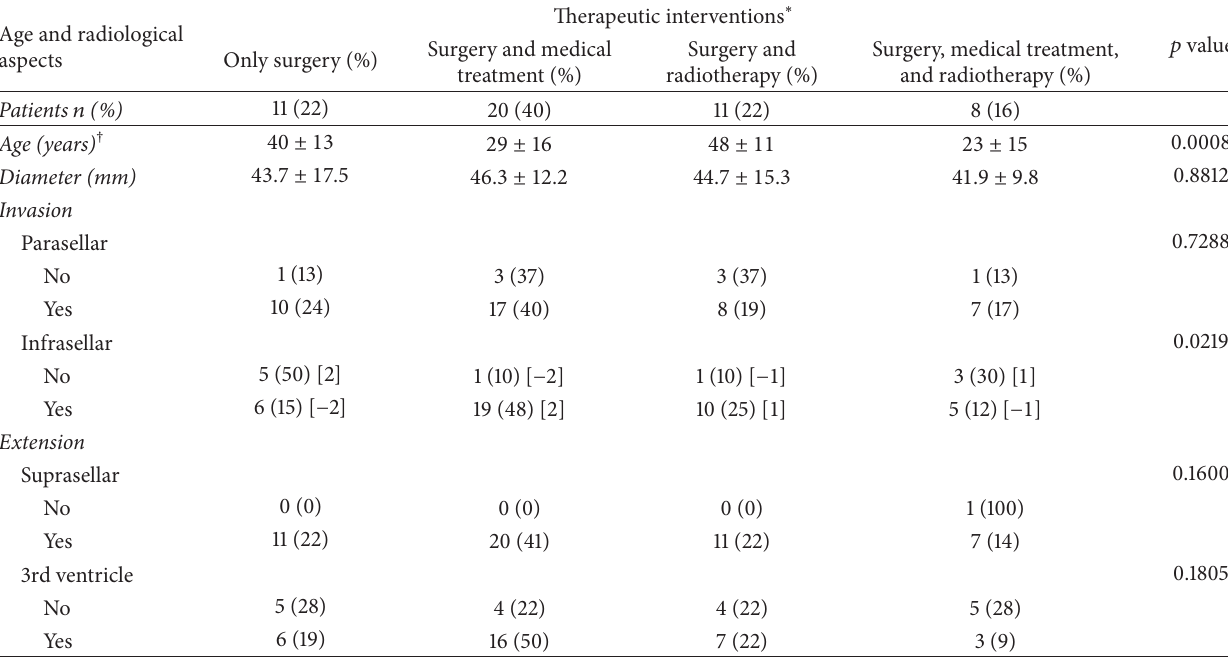
Table 4: Clinical and radiological features and therapeutic